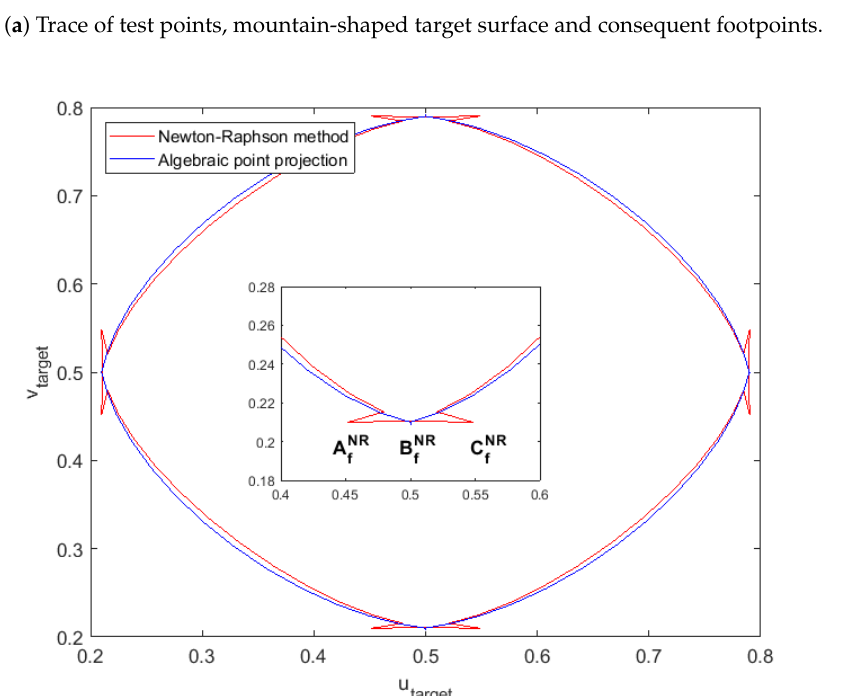
Figure 20. Illustration of the robustness of the 3D algebraic point projection algorithm involving test points whose mathematical footpoints do not exist. ( a ) Trace of points which are projected onto mountain-shaped target surface using both methods. ( b ) Parameters of footpoints on target. The solution does not exist near the four mountain ridges of G 0 continuity as shown in the four corner regions of ( b